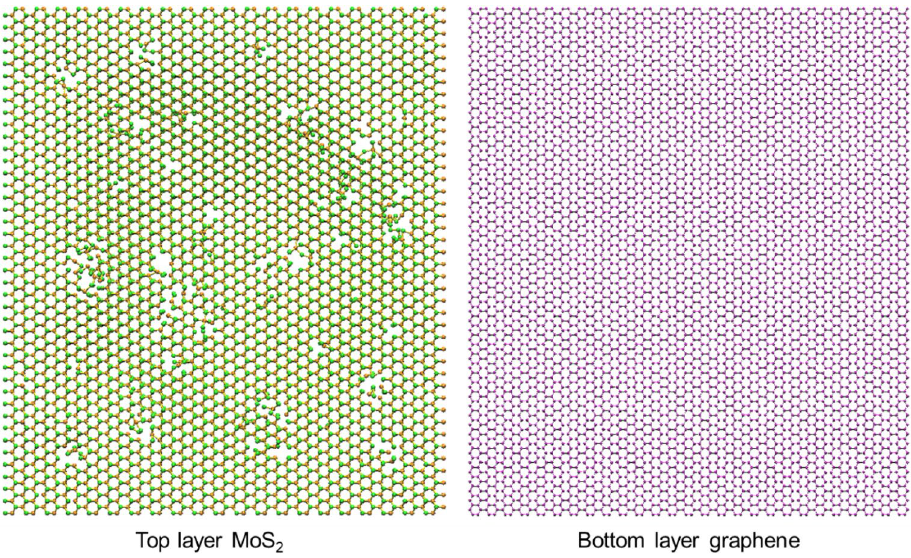
Figure 2. Generation of defects in suspended heterostructure layers. Irradiation energy is 100 eV and irradiation dose is 6.6 × 10 13 /cm 2